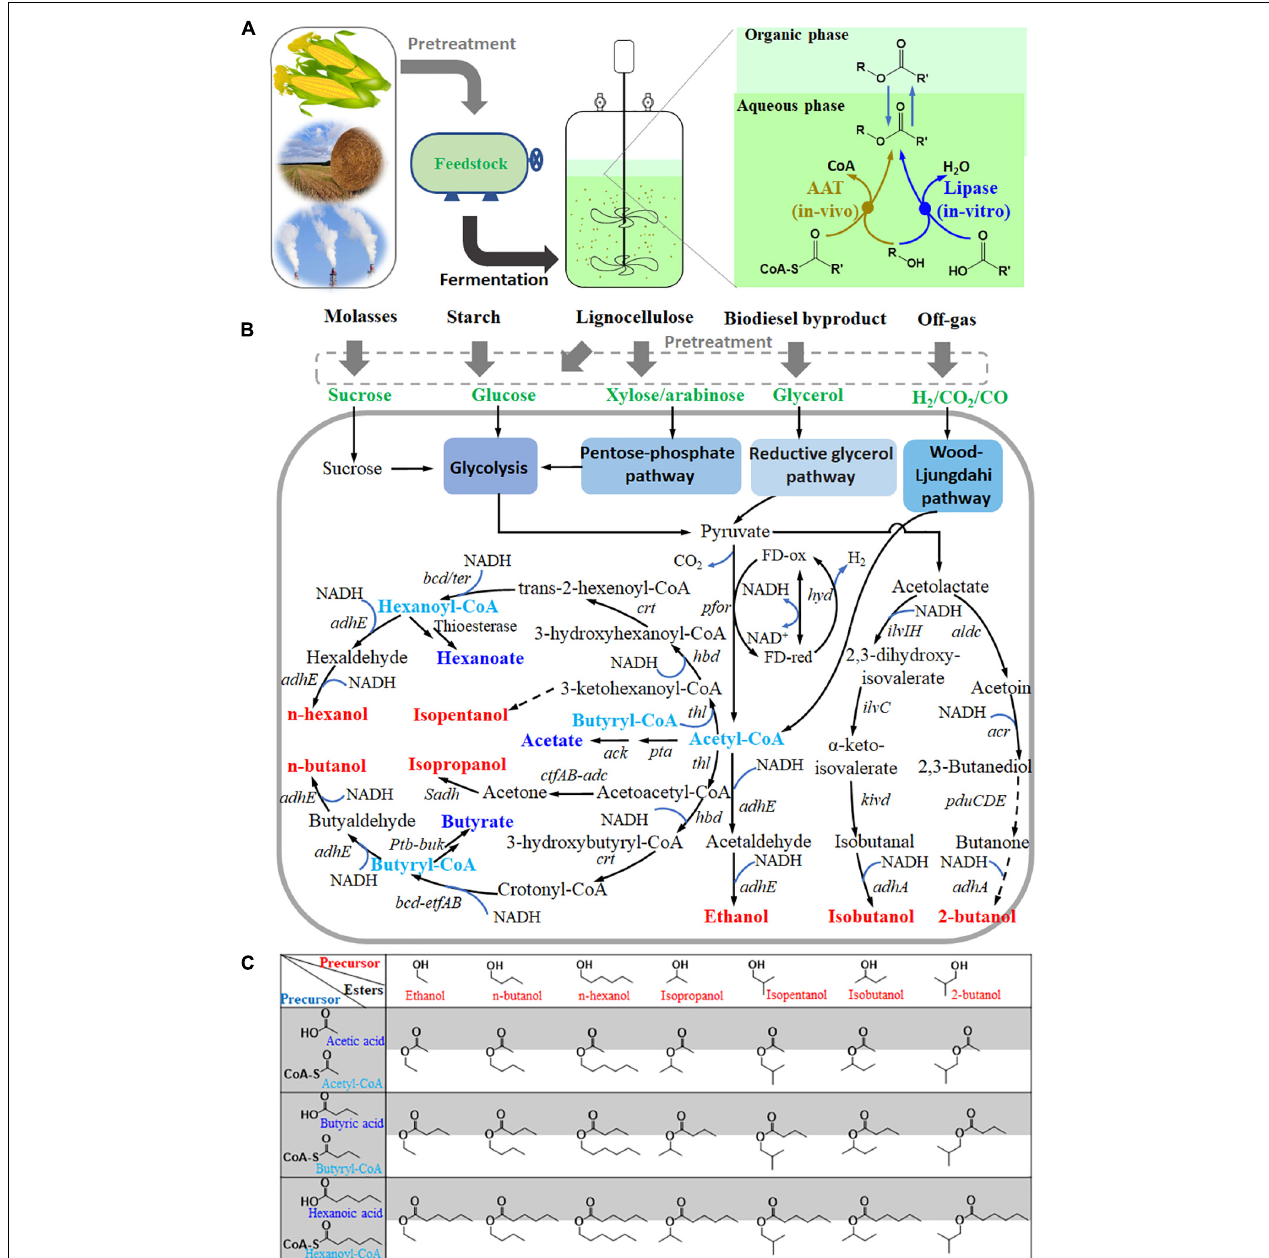
FIGURE 1 | Clostridia are promising cell factories for short- and medium-chain ester production. (A) , process and methods for ester production by Clostridia from various feedstocks; (B) , metabolic pathway for ester precursors (short-chain acids or acyl CoA, and alcohols) in some Clostridia; (C) , matrix of esters putatively produced by Clostridia based on the above precursors. pfor , pyruvate: ferredoxin oxidoreductase; thl , acetyl-CoA acetyltransferase; hbd , beta-hydroxybutyryl-CoA dehydrogenase; crt , crotonase; bcd/ter , butyryl-CoA dehydrogenase; adhE or adhE1/2 , acetaldehyde/ethanol dehydrogenase; pta , phosphotransacetylase; ack , acetate kinase; ctfAB , acetate/butyrate-acetoacetate COA-transferase; adc , acetoacetate decarboxylase; Sadh , primary/secondary alcohol dehydrogenase; ptb , phosphate butyryl-transferase; buk , butyrate kinase; hyd , ferredoxin hydrogenase; bdhA/B , butanol dehydrogenase; edh , alcohol dehydrogenase; ilvIH , acetolactate synthase; ilvC , keto-acid reductoisomerase; kivd , α -ketoisovalerate decarboxylase; adhA , alcohol dehydrogenase; aldc , acetolactate decarboxylase; acr, acetoin reductase; pduCDE , diol dehydratase. Dash lines indicate putative pathways.